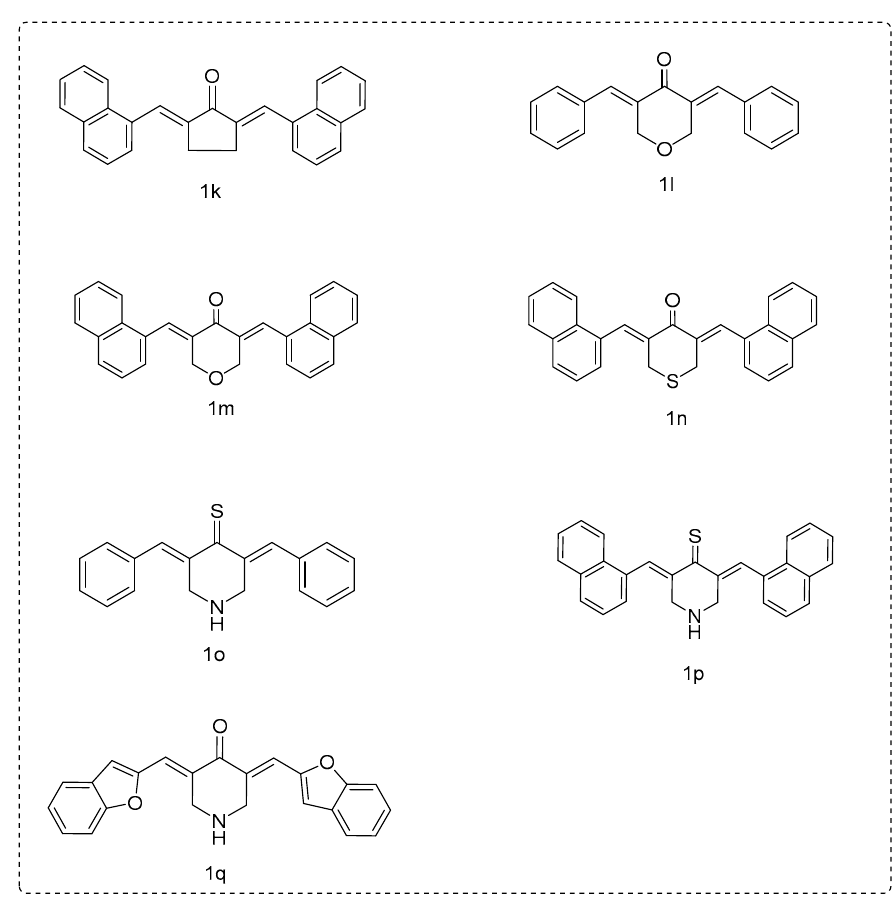
Figure 6. Miscellaneous curcumin analogues.